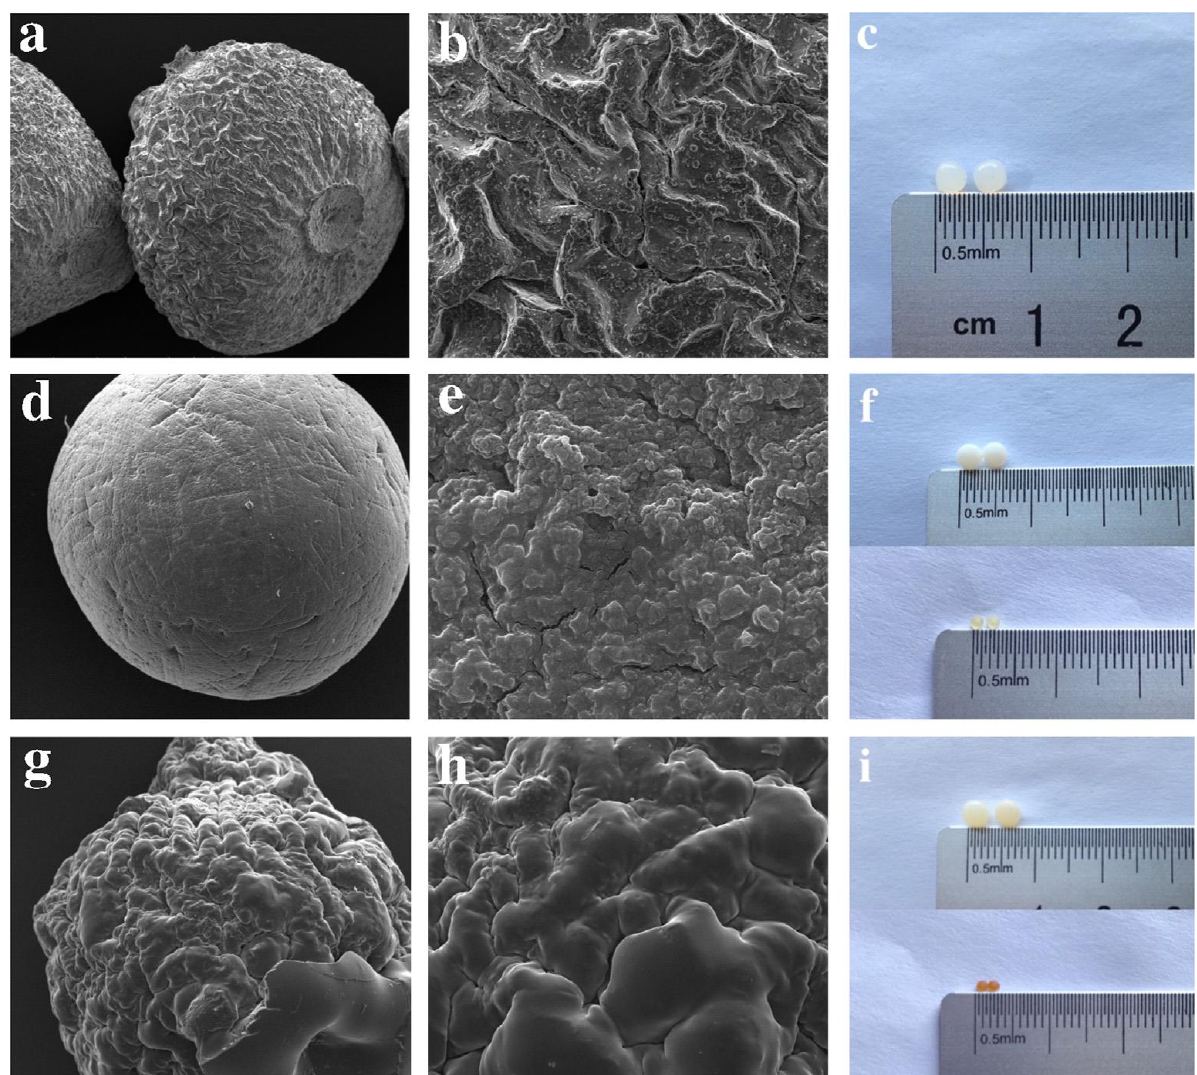
Figure 1. SEM images of ( a , b ) CS, ( d , e ) EPCS@PEI, ( g , h ) GACS@PEI beads. Photographs of wet and dried beads of ( c ) CS,